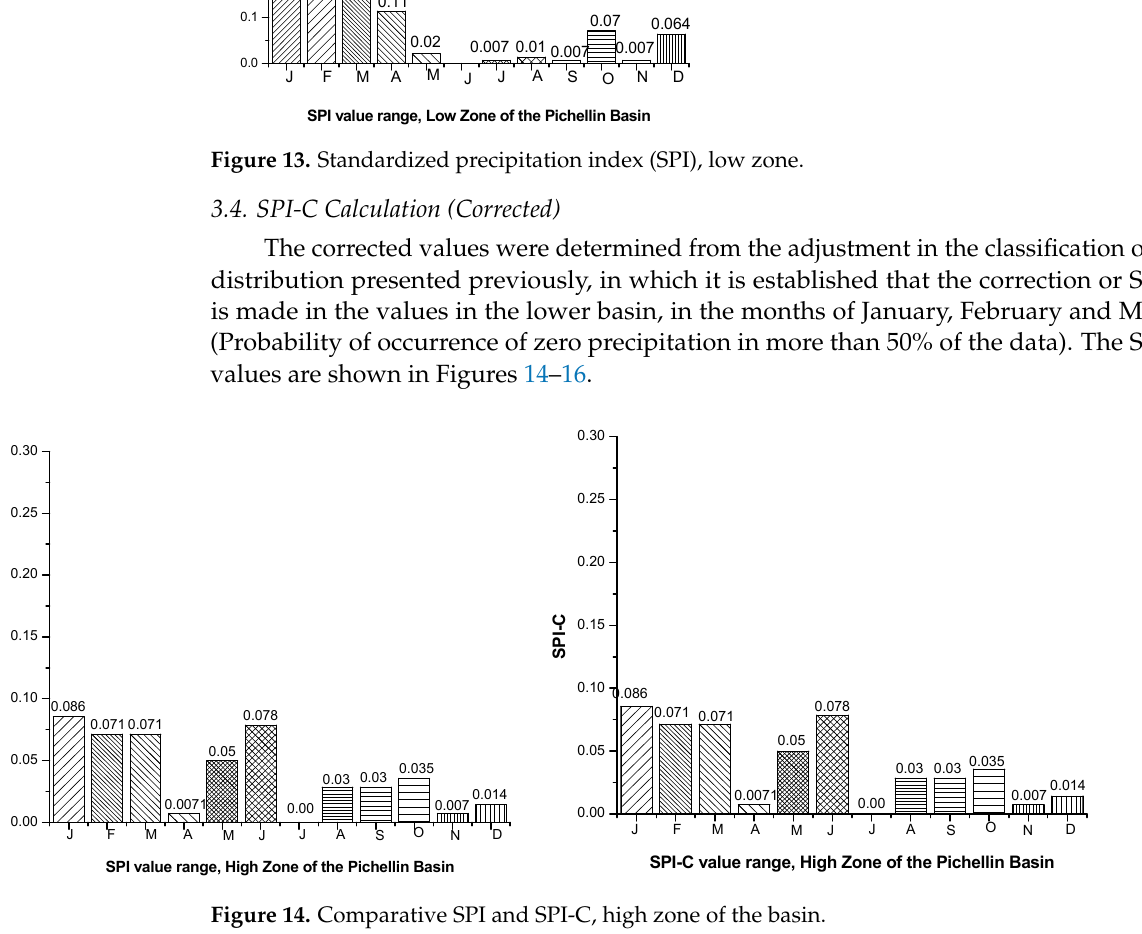
D Figure 15. Comparative SPI and SPI-C, middle zone of the basin.